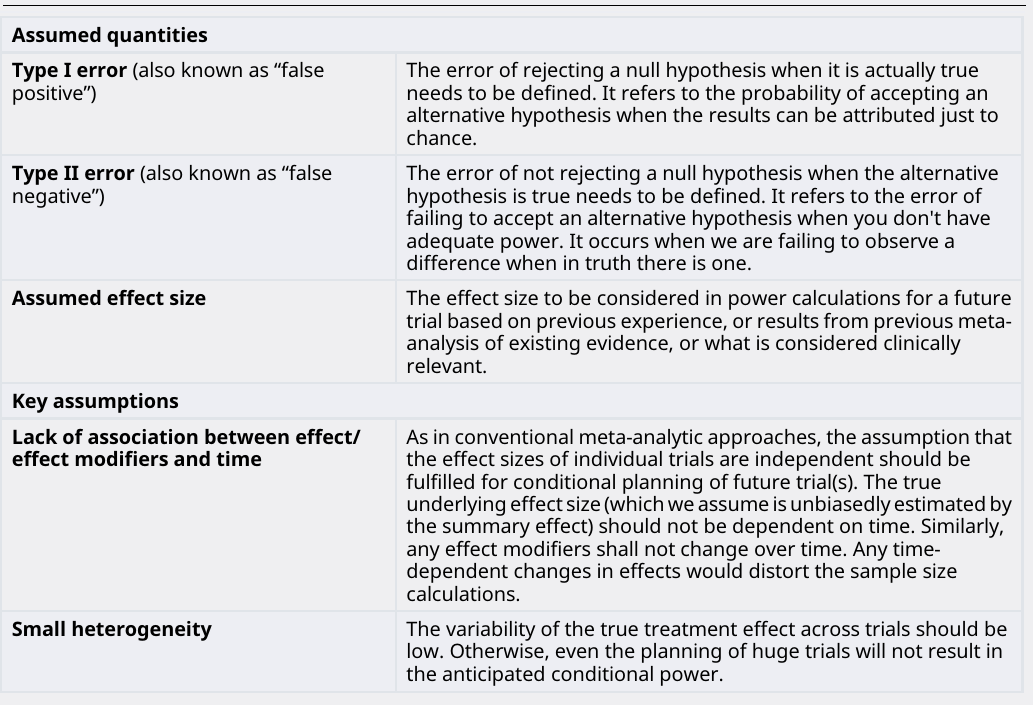
(n=396 patients) were deemed eligible (Table 1). Random allocation was 1:1 in 5 trials 21 – 27 and 2:1 in one 19,20 of the trials giving more weight to patients randomized to the active intervention. Two of the trials 23 – 25 were not